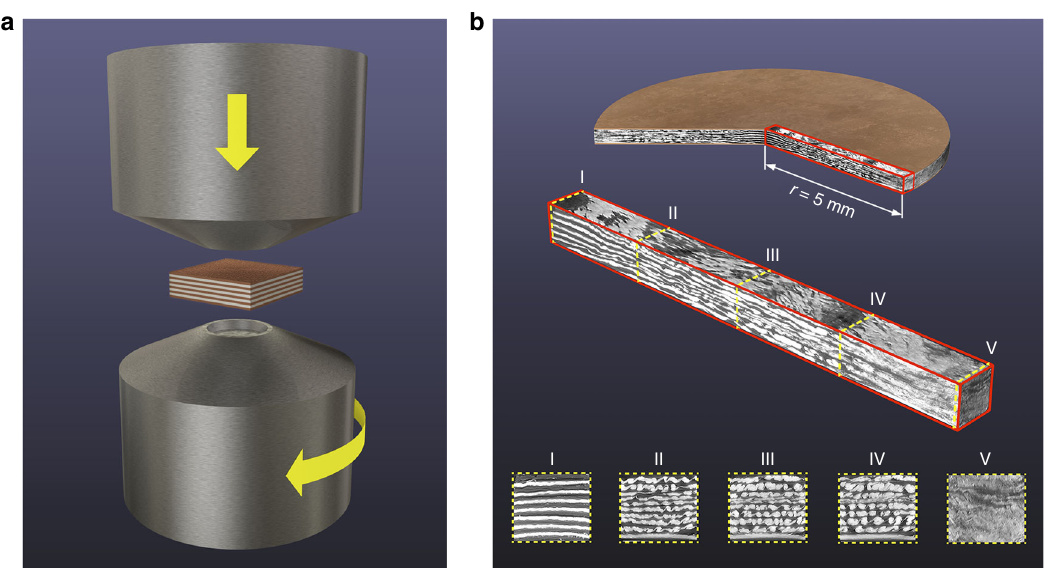
Fig. 1 Schematics of the deformation method, the multilayer, and the volume section used for tomography examination. a A schematic drawing showing the high-pressure torsion (HPT) setup and a multilayer sample placed between the anvils of the apparatus. The process applies a shear stress parallel to the layers and results in the formation of a disk-shaped sample. b A parallelepiped-shaped volume section, cut out of the processed disk and subsequently imaged by 3D X-ray synchrotron tomography. The tomographic images show selected cross-sections of the volume element, cut at different distances from the center of the disk, with (I) representing the center (and thus having experienced the lowest strain) and (V) typifying the microstructure at the edge of the disk (and thus having been subjected to the highest